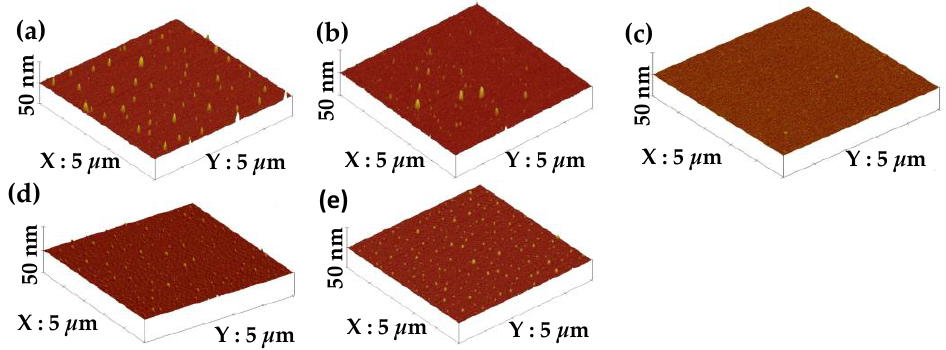
Figure 5. Surface roughness of the films synthesized from the gas flow ratios of ( a ) 0; ( b ) 0.25; ( c ) 0.5; ( d ) 0.75; and ( e ) 1, respectively. Appl. Sci. 2017 , 7 , 56